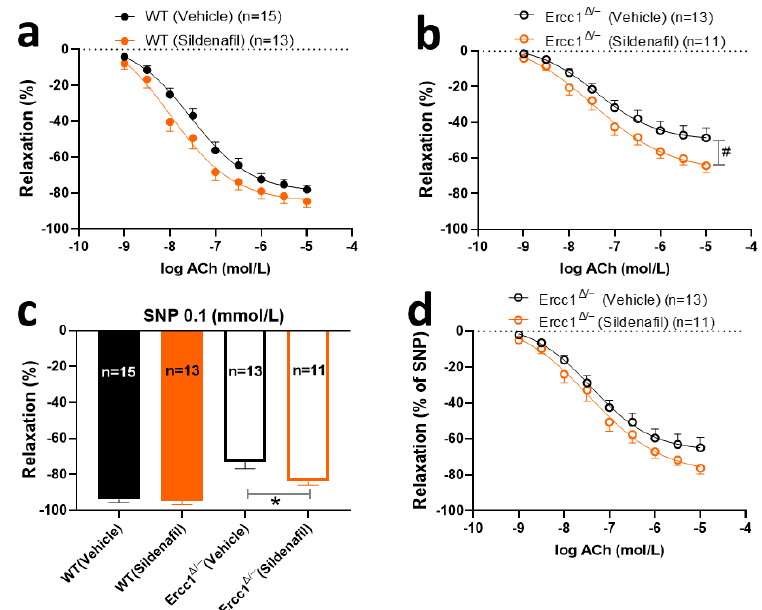
Figure 4. The effects of 8 weeks of treatment with sildenafil in drinking water on endothelium- dependent ( a, b ) and -independent responses ( c ) in Ercc1 Δ / − mice ( b, c ) and WT littermates ( a, c ), measured in aortic rings in ex vivo organ bath experiments. Reponses to Ach in Ercc1 Δ / − mice corrected for SNP ( d ). Data were calculated relative to the precontraction produced by U46619 in each ring. Values are expressed as means ± SEM; n, number of mice; *, p < 0.05, t-test; #, p < 0.05, GLM for repeated measures.